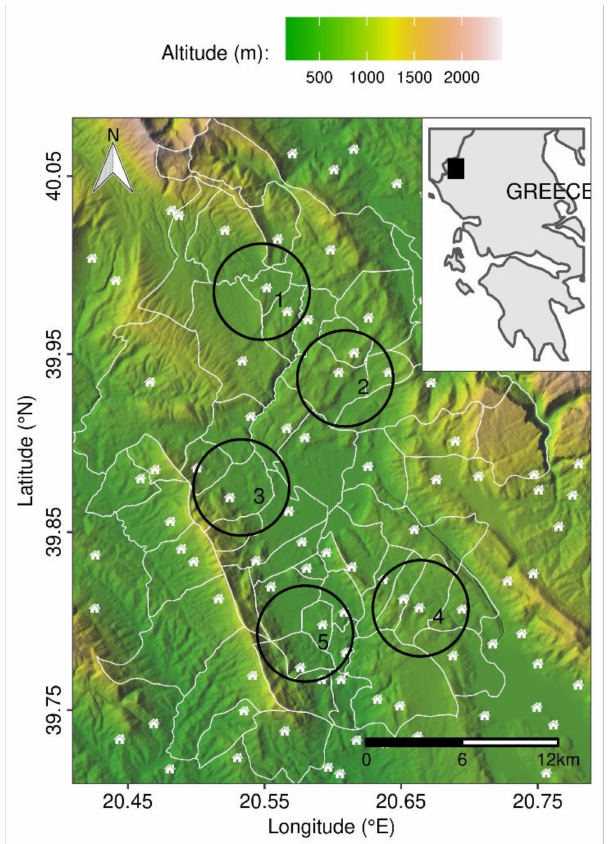
Figure 1. The five circles constituting the study area’s sites. The inset’s black-filled rectangle shows them in the region. White lines indicate boundaries of local municipal districts, and white symbols are for